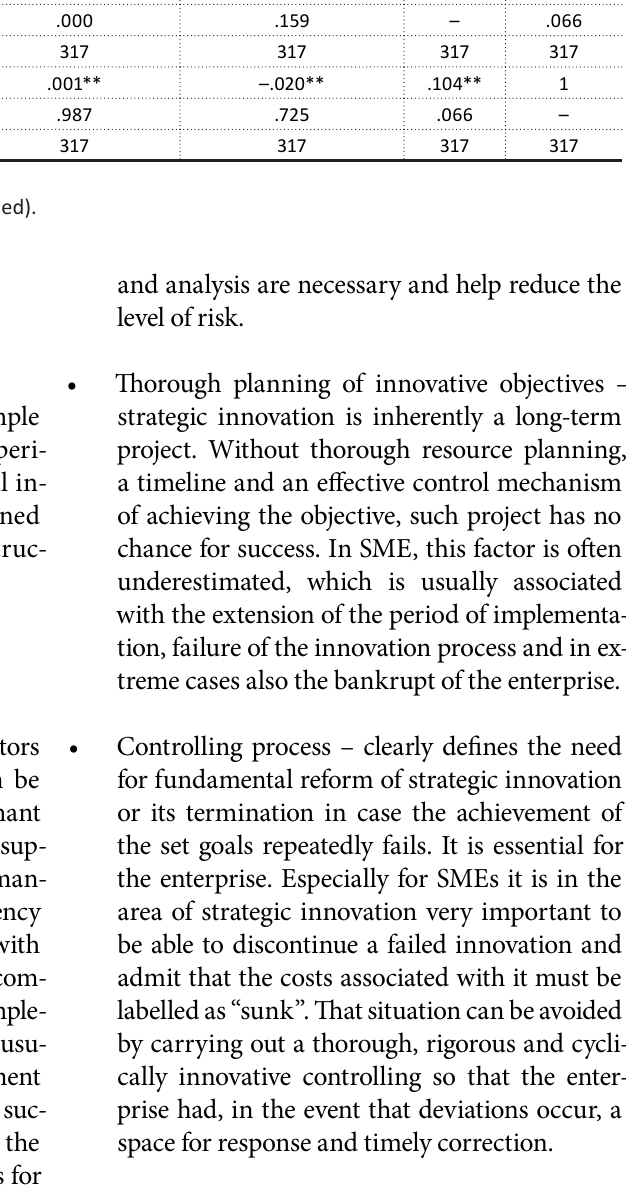
Table 2. Correlation analysis between the innovation plan and the financial analysis indicators